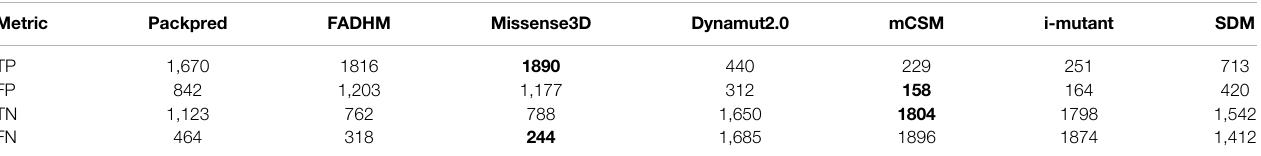
TABLE 3 | Confusion matrix values for the different prediction methods. The values in bold font show the best in each category. TP, FP, TN, and FN stand for true positive, false positive, true negative, and false negative, respectively. Metric